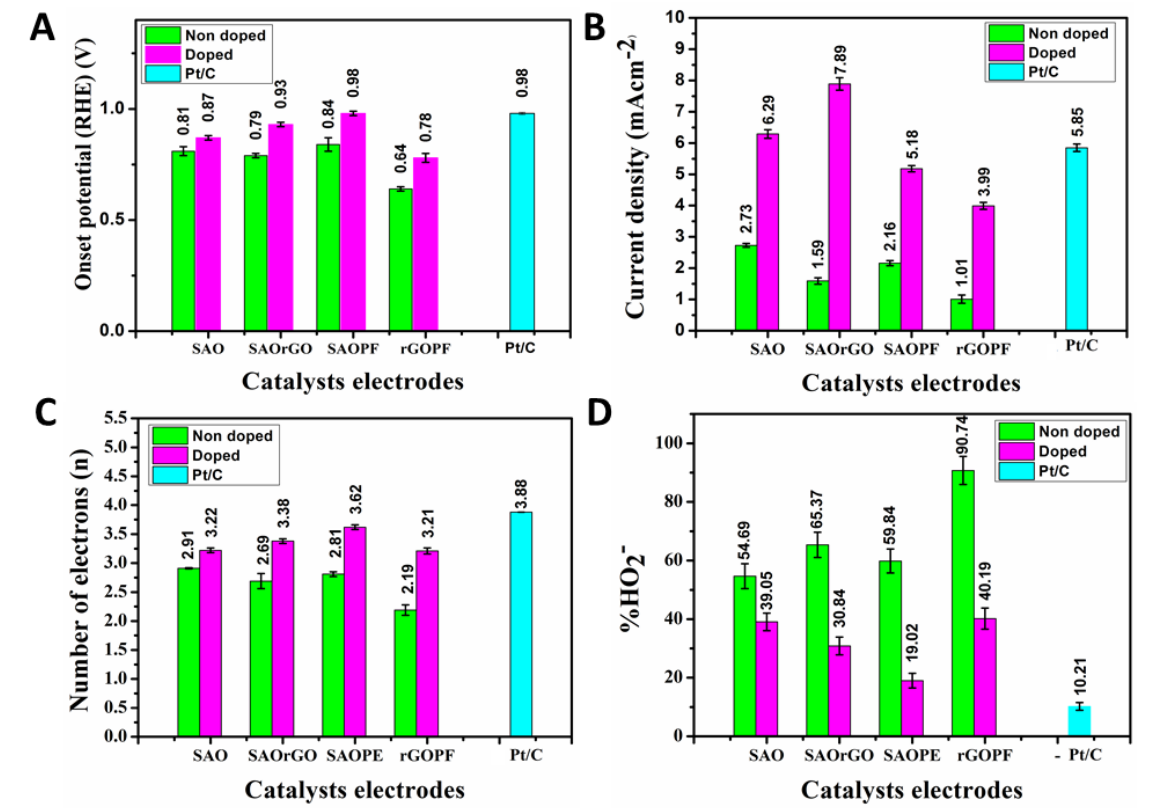
Figure 5. ( A ) Onset potential, ( B ) current density at 0.00 V (RHE), ( C ) comparison of number of electrons (at 0.50 V) and ( D ) % HO 2 − (at 0.50 V) of nondoped and doped SAO, SAOrGO, SAOPF, rGOPF and Pt/C catalysts in oxygen saturated 0.10 M KOH electrolyte at 2000 rpm at a scan rate of 10 mV/s.